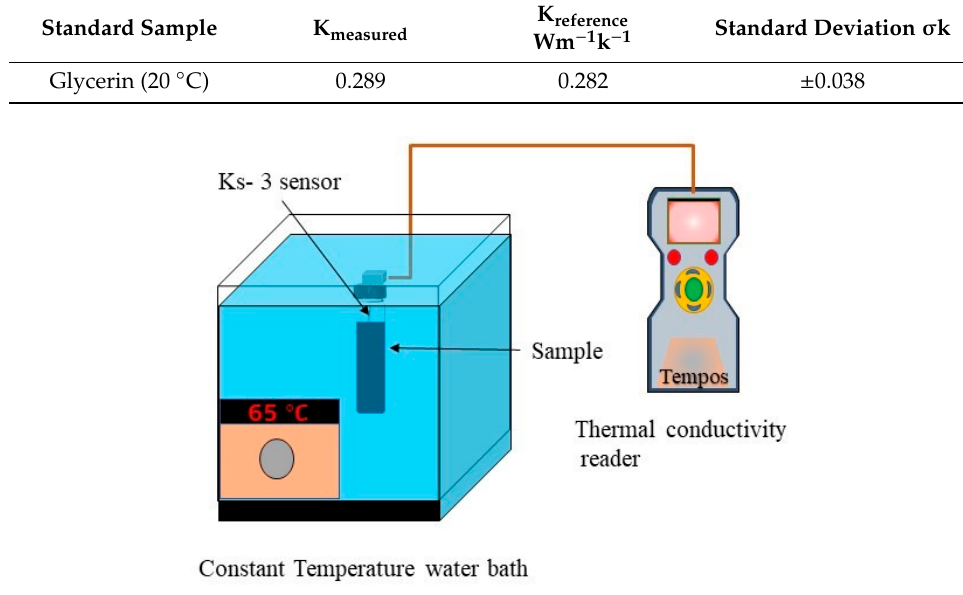
Figure 1. Setup used for measuring thermal conductivity.